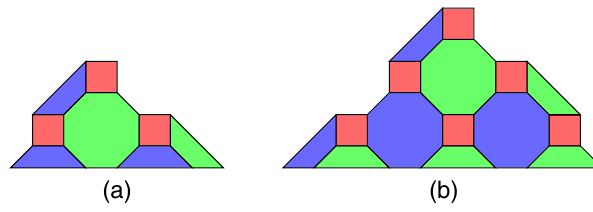
2-local . — There are seven square plaquettes that share six sides, and one octagonal plaquette that shares six sides with square plaquettes, so the square plaquettes are 7 × ð 4 Þ − 6 ¼ 36 , the octagonal plaquette is ð 8 2 and the total is 58.